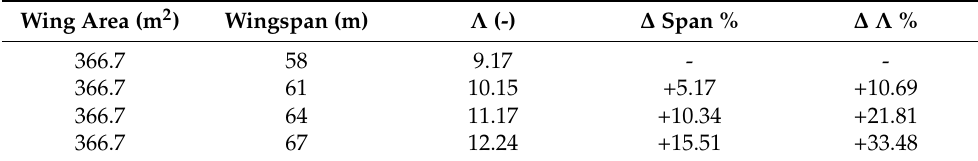
Table 7. Numerical values of the wings considered and their relative variation w.r.t. Λ = 9.17.